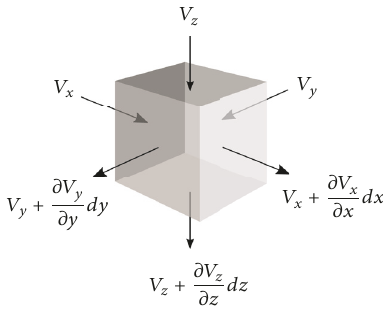
Figure 1: Change in flow velocity of a sample voxel.